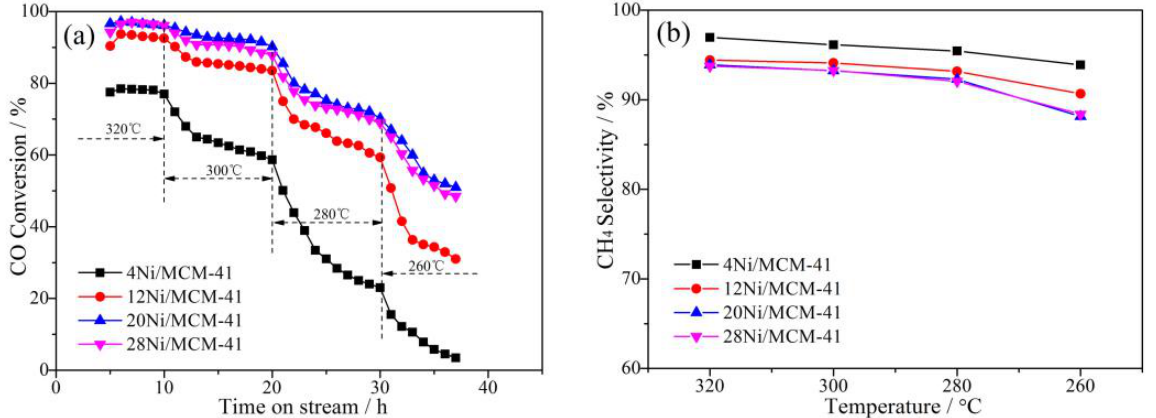
Figure 2. Effect of reaction temperature on catalytic performance for CO methanation over x Ni/MCM-41 catalysts. ( a ) CO conversion, ( b ) CH 4 selectivity.